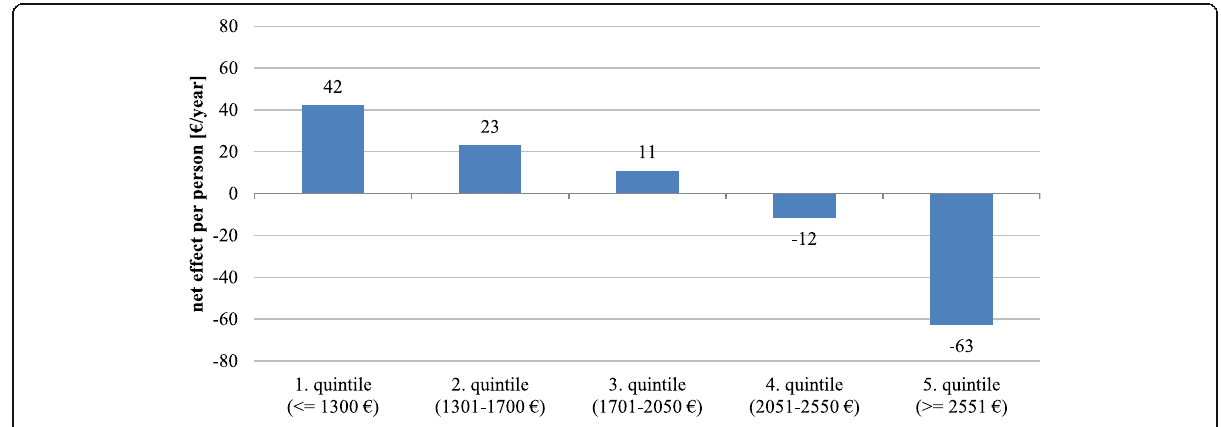
Fig. 2 Net effects of carbon taxation, differentiated by household income (OECD household equalized income) per